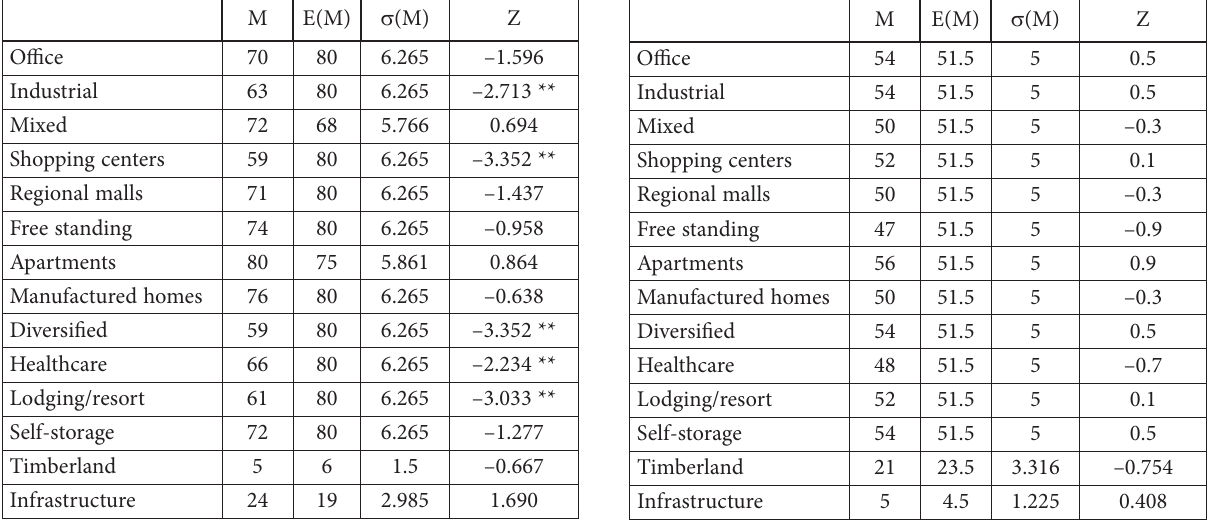
Table 6. Non parametric runs test results with structural